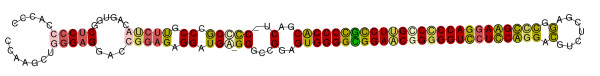
For the contig Ss1.1-rese12c_n15.5 we predicted three non-overlapping   conserved secondary RNA structures. Inside one novel RNA structure prediction,   we found a conserved microRNA structure by RNAmicro at the conread positions 87   to 220 in the positive reading direction with p = 1, which is   illustrated in Figure 6. The alignment to cow, human chromosome 11 (3'UTR of   hypothetical protein NM_001007139 (GenBank)) and mouse has an average sequence   identity of 71.5%. The structure was calculated by RNAalifold and colored by colorrna.pl, being both from the Vienna RNA Package [75].